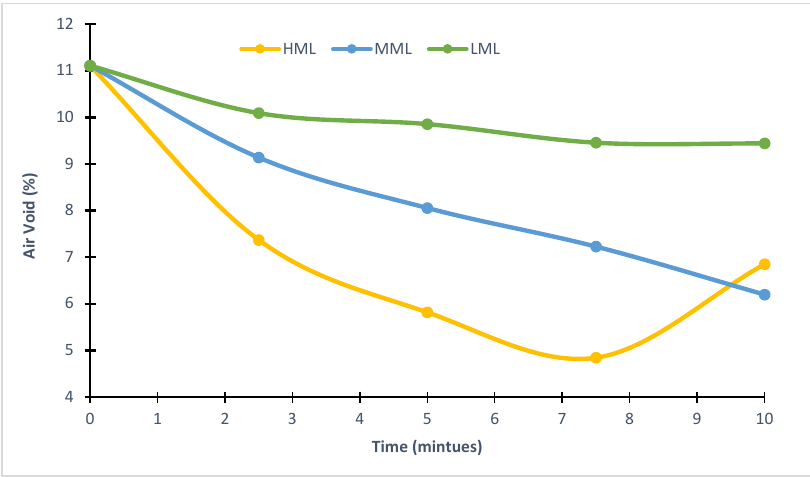
Figure 5. Effects of varying MW power and duration on air voids of CBEMs containing 5.5% PSA .